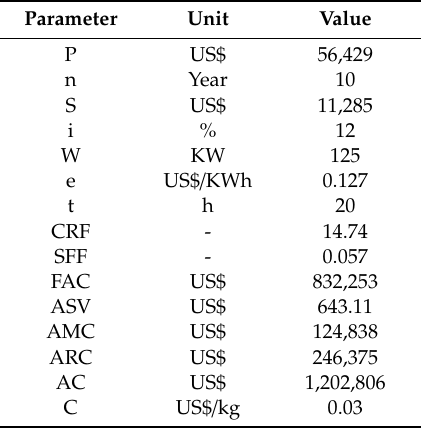
Table 4. Freshwater cost